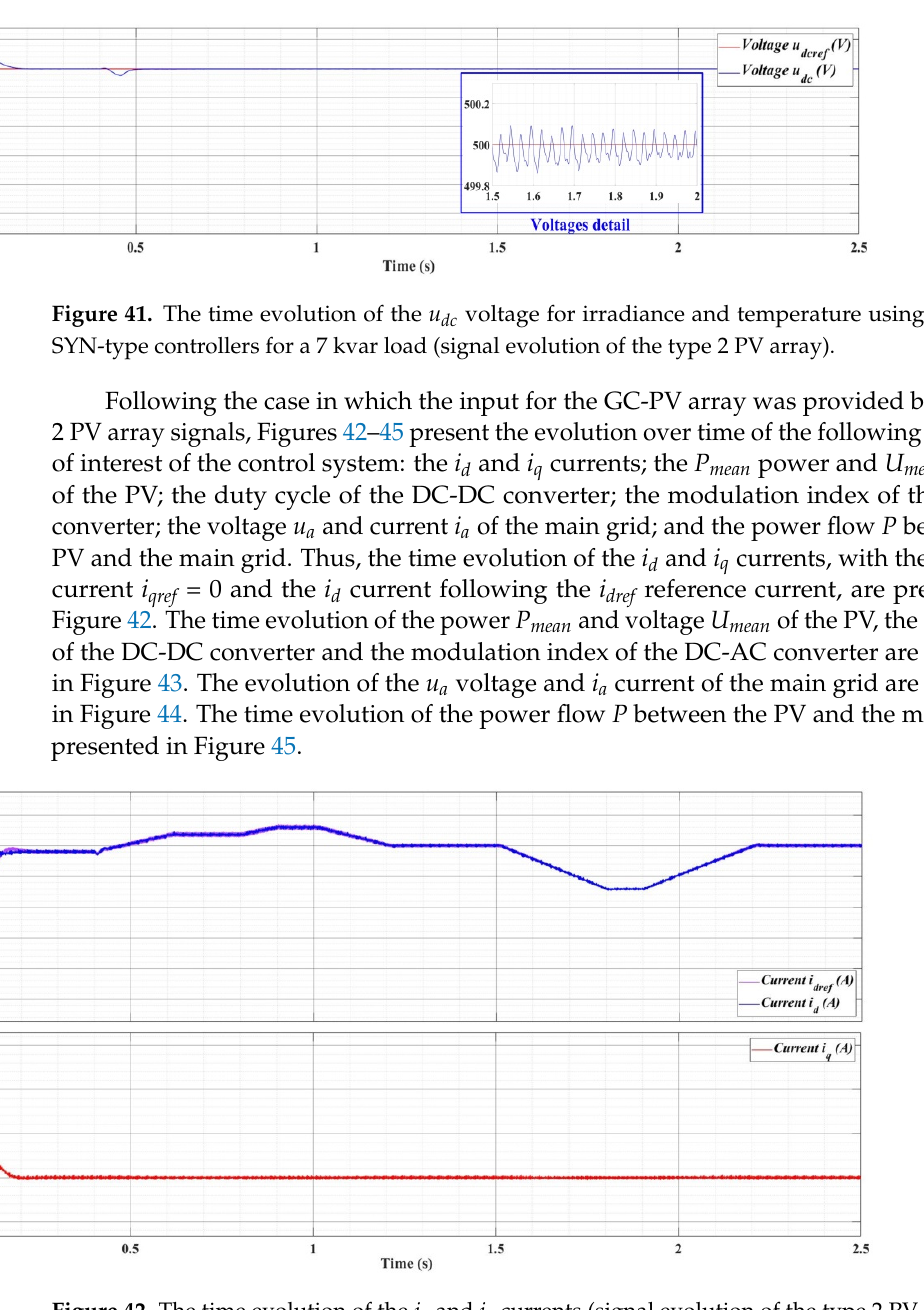
Figure 42. The time evolution of the i d and i q currents (signal evolution of the type 2 PV array).